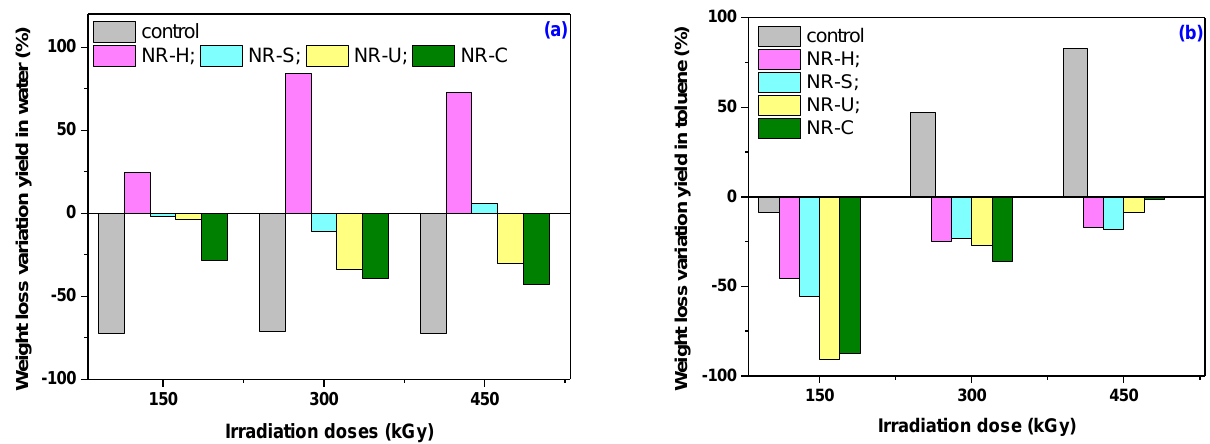
Figure 4. The weight loss variation yield in water ( a ) and toluene ( b ). It was expected that the composite materials reinforced with hemp and sawdust to exhibit the highest percentages of water uptake due to the strong hydrophilic character of natural fibers. As seen in Table 7, the water uptake of non-irradiated NR-H (12.13%) is higher than of NR-S (6.64%) due to the higher content of cellulose. The number of OH groups is high as the cellulose content is also high. The OH groups attract water molecules and the water uptake increases. By electron beam irradiation at a dose of 450 kGy, the percentages of water uptake at equilibrium have increased for control sample, NR-S and NR-C, and decreased for NR-H and NR-U. The results obtained in case of composites reinforced with mineral fillers may be explained by the presence of the maleinated natural rubber (NR-g-AM) that acts as a plasticizer and favors a good interaction at the interface between the hydrophobic matrix and hydrophilic filler. Although water absorption is low for NR-C and NR-U, a decrease with the irradiation dose for NR-U and an increase for NR-C was observed. The result obtained for NR-C can be explain by the agglomeration of the filler that could led to the formation of so called “interfacial voids” at the particle- polymer interface with the consequence of water uptake increasing [6]. The decreasing of water uptake for NR-U with the irradiation dose increasing indicates that the surface of precipitated silica becomes less hydrophilic, i.e., the silanol on the silica surface has degraded. The free radicals formed by irradiation can recombine or diffuse to the surface, making it reactive and accelerating degradation reactions in the vicinity of the filler surface. Thus, precipitated silica becomes more hydrophobic and interacts more easily with the polymeric matrix in its vicinity forming covalent bonds that increase the adhesion between them [60]. As seen in Table 7, the biggest weight loss in water was registered in the case of composites reinforced with hemp, NR-H, and irradiated at 300 and 450 kGy. Unexpected results were obtained for irradiated NR-S (the decreasing of weight loss in water with the irradiation dose increasing). Correlating these results with those obtained for cross-linking degree which decreased with the irradiation dose for NR-H but increased for NR-S, it can be said that degradation effect in NR-H is more pronounced than in NR-S. The effect of EB irradiation treatment was evaluated in terms of weight loss variation yield of the irradiated versus non-irradiated samples in water and toluene and the tendency is presented in Figure 4a,b. The weight loss variation yields in water of control sample, NR-U, NR-C and NR-S at 150 and 300 kGy were negative while of NR-H and NR-S at 450 kGy were positive. These results, together with those previously obtained, show that the electron beam irradiation led to the increasing of cross-linking degree (Figure 2b) and rubber-filler interaction (Table 5), especially for the irradiation dose of 450 kGy. It can be said that the addition of minerals, precipitated silica and chalk, in the natural rubber matrix led to the obtaining of more resistant and stabile composite materials in radiation field than the addition of organics, hemp and sawdust. Quite opposite to the results obtained in the case of water uptake at equilibrium are the ones obtained in toluene. As seen in Table 7,